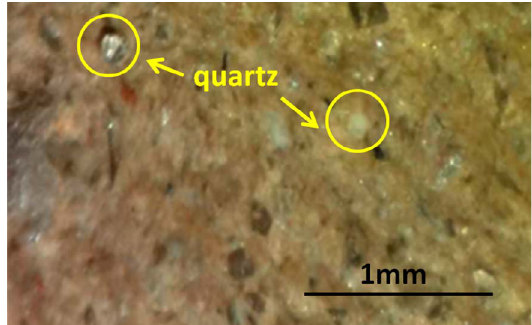
Figure 9. Fracture surface of the plain clay ceramic without incorporated waste.